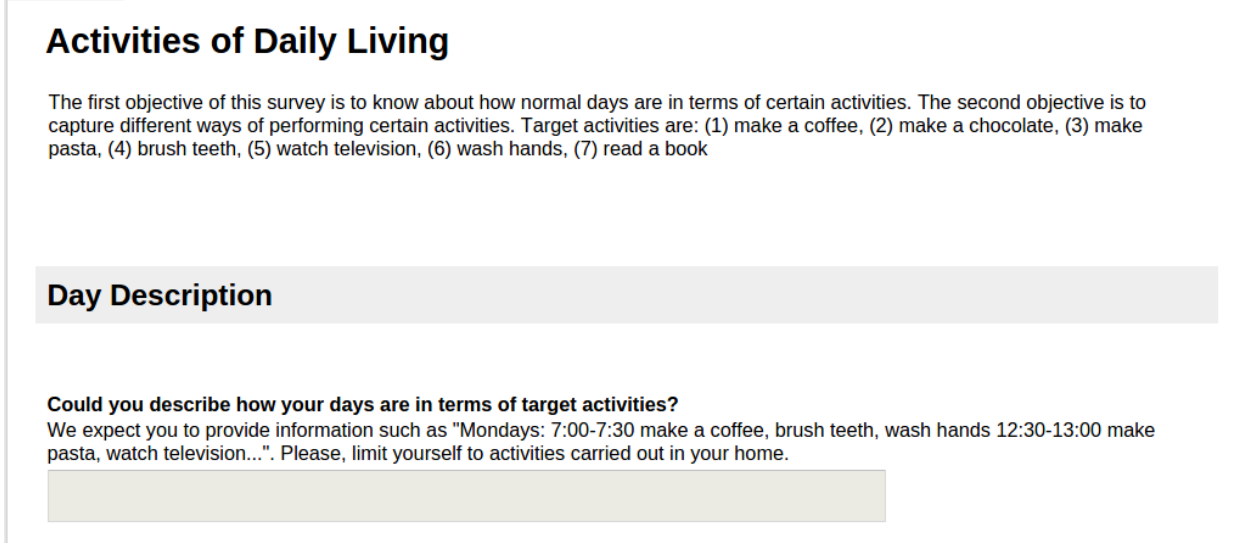
Figure 2. The first part of the survey. A brief introduction can be found where the aim of the survey is explained, continuing with the behaviour model